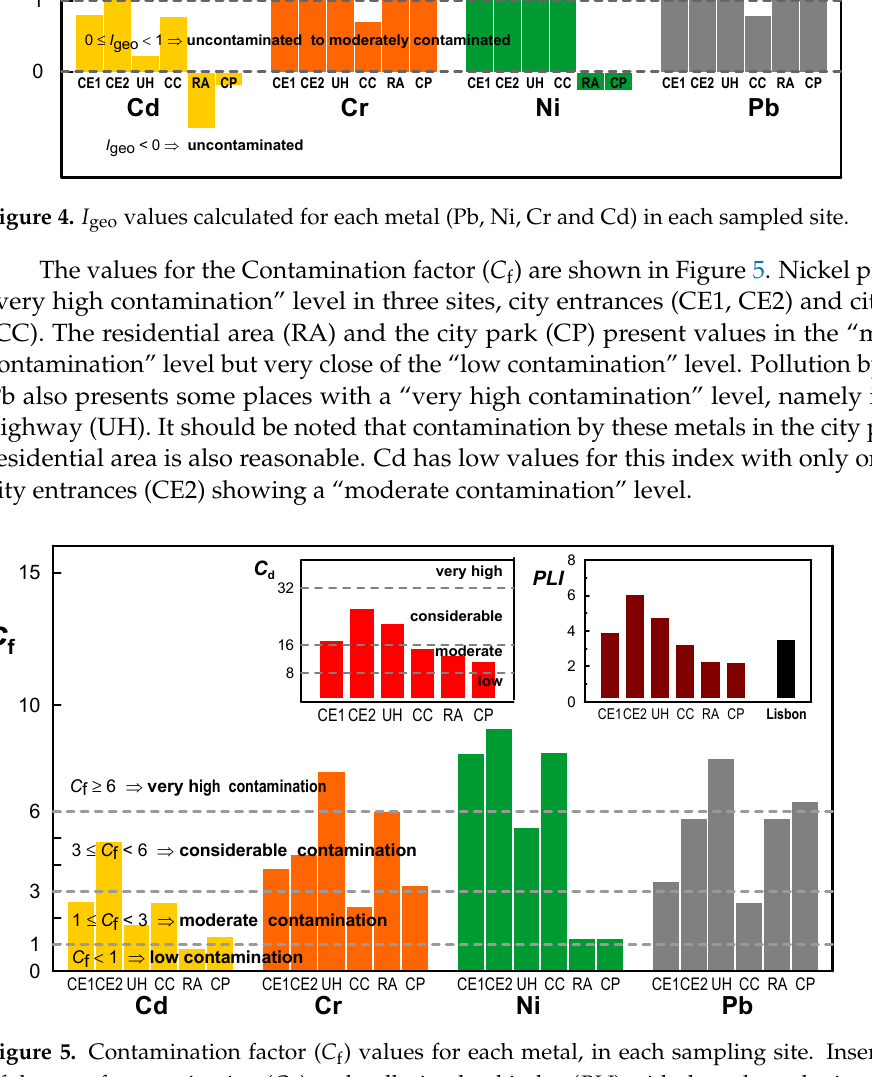
Figure 5. Contamination factor ( C f ) values for each metal, in each sampling site. Insert: values of degree of contamination ( C d ) and pollution load index ( PLI ) with the values obtained for each sampling site and the global PLI calculated for the city of Lisbon.